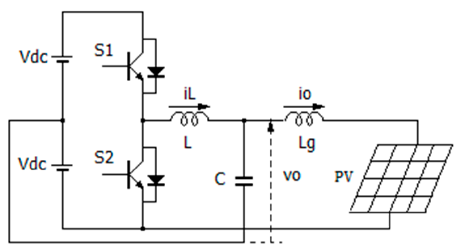
Figure 5. PV connected inverter circuit.